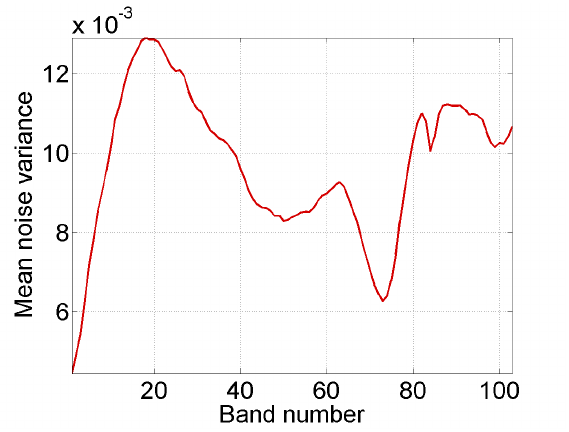
Figure 3. Mean noise variance in each band ( SNR INPUT = 20